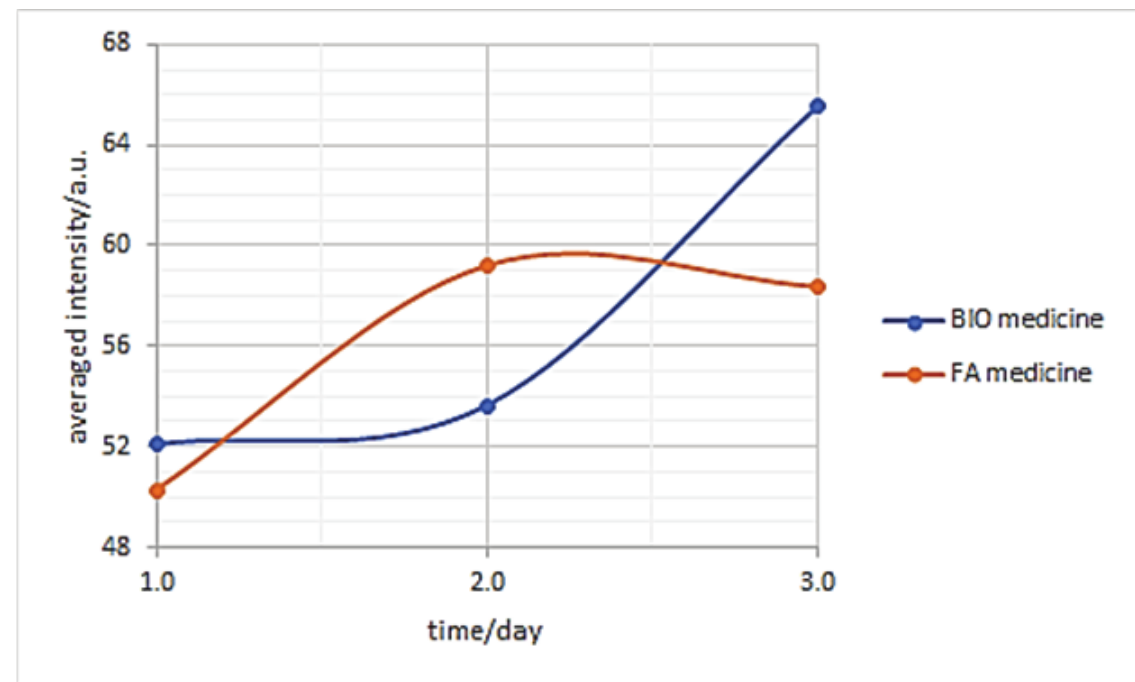
Figure 2. The change of average intensity of CNTs functionalized with fluorescein isothiocyanate and biotin, and fluorescein isothiocyanate and folic acid over the